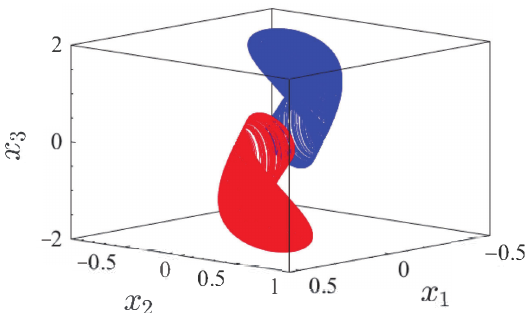
Figure 11. Dynamical behaviors with changes in initial value x 2 ( 0 ) of system (15). ( a ) Bifurcation diagram; ( b ) LEs.